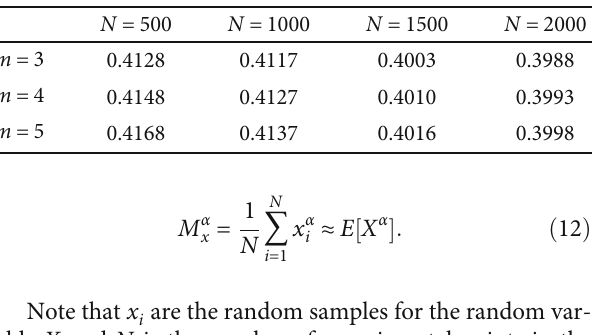
Table 2: The value of the objective function with penalty